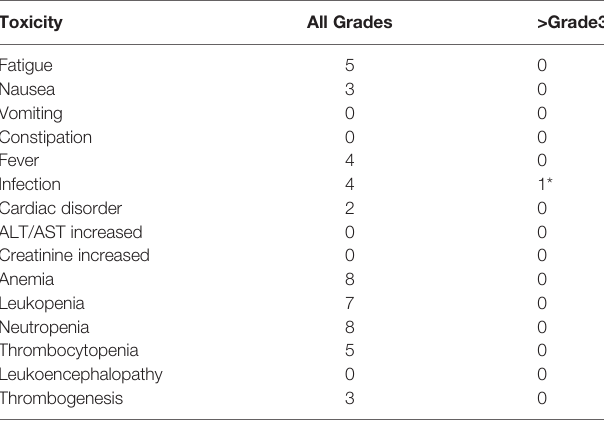
TABLE 3 | Adverse events (N = 38).